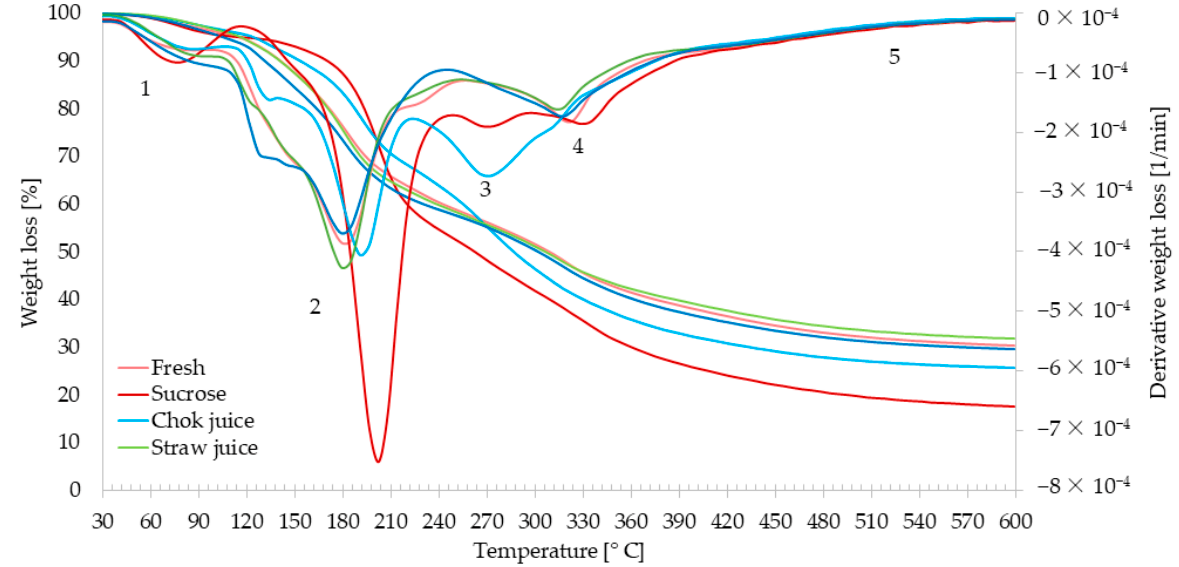
Figure 10. Effect of the type of osmotic agent (sucrose and fruit concentrates) on the sugar content in osmodehydrated strawberries.